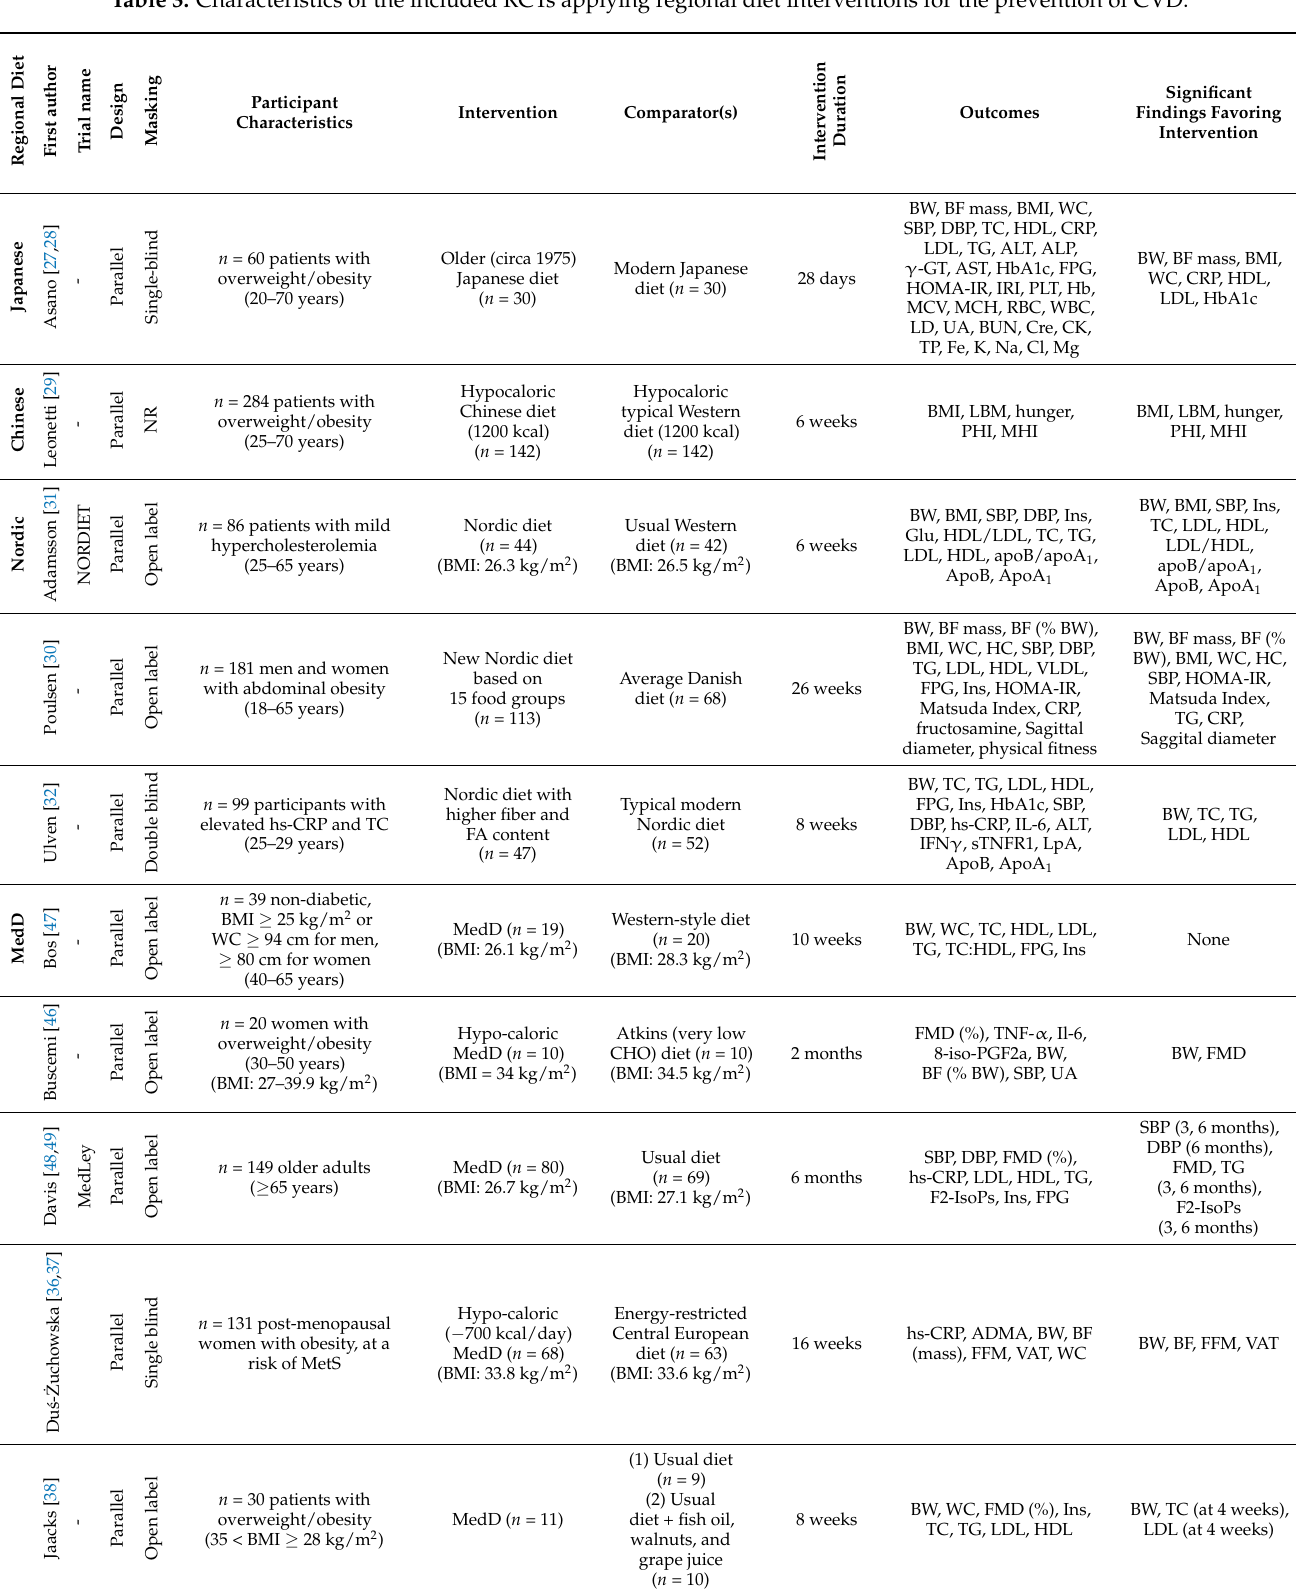
Table 3. Characteristics of the included RCTs applying regional diet interventions for the prevention of